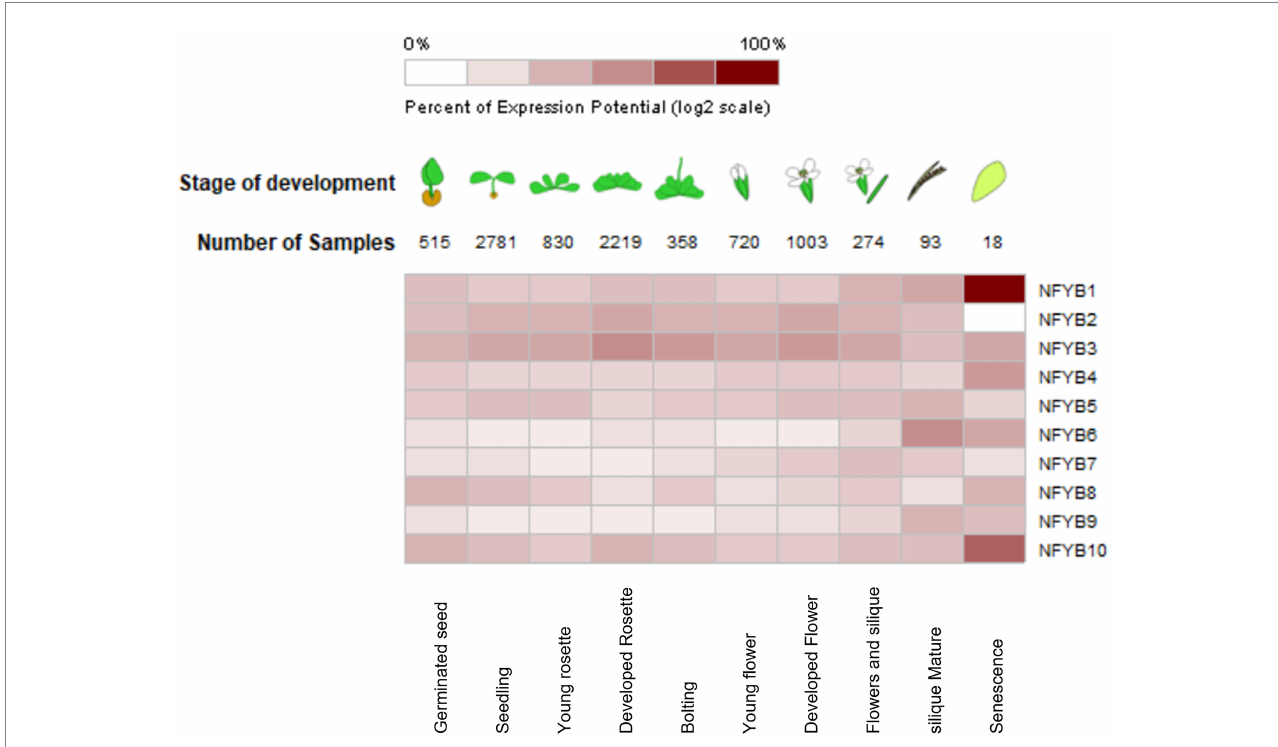
FIGURE 5 Heat-map showing the relative expression levels of AtNF-YB genes at different developmental stages of Arabidopsis thaliana compiled from the microarray datasets. Values and colour coding was based on the expression levels, where dark colouring constitutes highest expression as indicated by the scale and is the result of clustering by similarity of